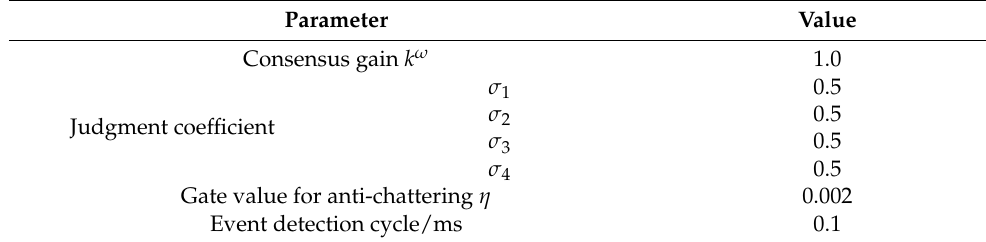
Table 5. Event-triggered consensus algorithm parameter.